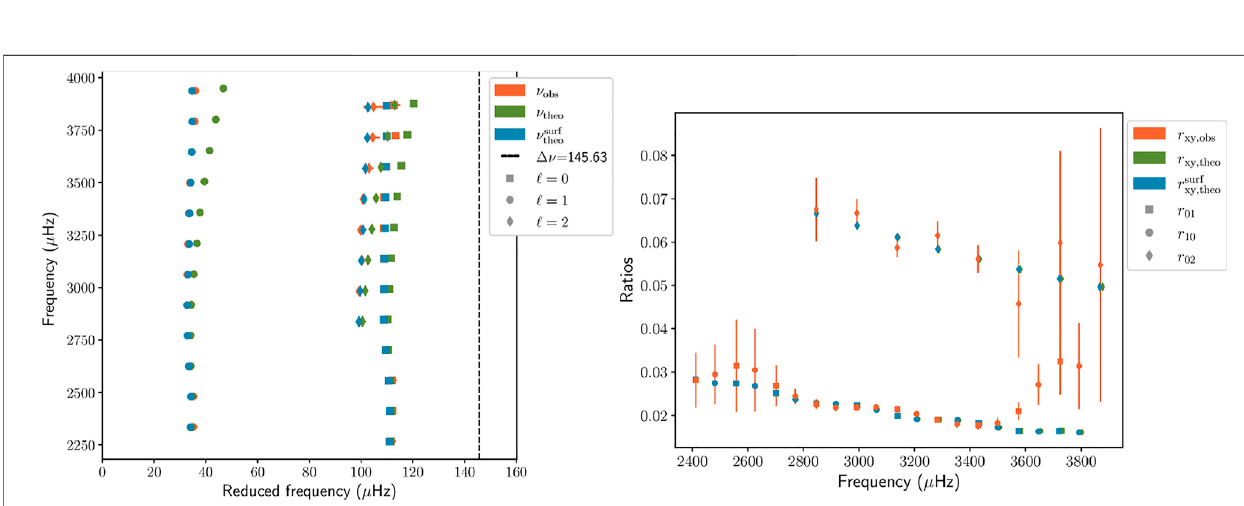
FIGURE2| Left :Illustrationoftheeffects ofsurfacecorrectionsfor theEchellediagramofKepler 93,showing thesigni fi canteffect oftheparametric corrections on high frequencies. Right : Frequency separation ratios for the data of the left panel, showing their low sensitivity to the empirical surface corrections as the blue and reen symbols are essentially the